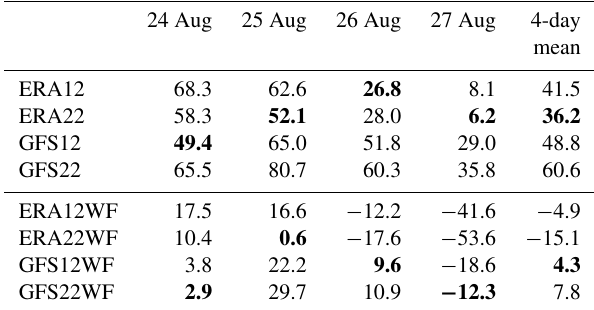
Table 4. RMSE of 10min total power (MW) of different model runs each day.